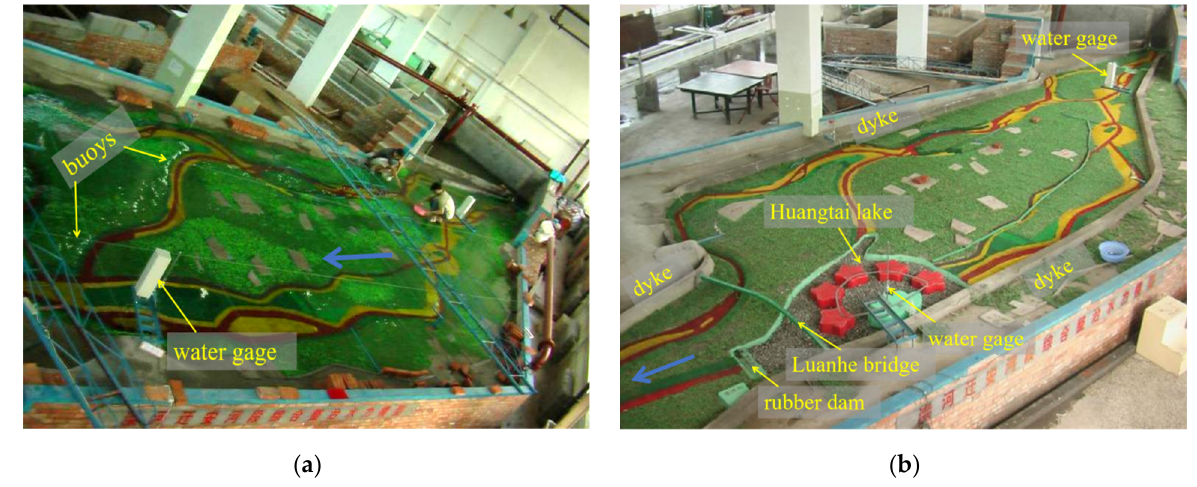
Figure 5. The hydraulic model of the regulated reach of the Luanhe River. ( a ) The model before regulation (Case S1). ( b ) The model after regulation (Case S2).